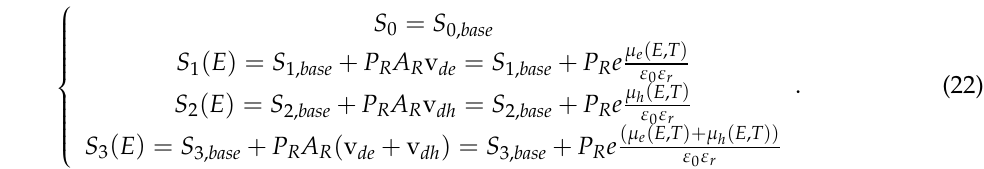
Figure 4. Field plots showing interaction of two opposite charge carriers in a background field of 1 kV/mm ( A , left) and 60 kV/mm ( B , right). The red circle is calculated using the critical recombination radius r cr according to Equation (21) and the half ellipsoid highlights the capture cross-section radius calculated with r ar . Note that the charge carriers are positioned to be just within the capture cross- section, such that the spacing differs by around one order of magnitude. A relative permittivity of 2.3 is used.